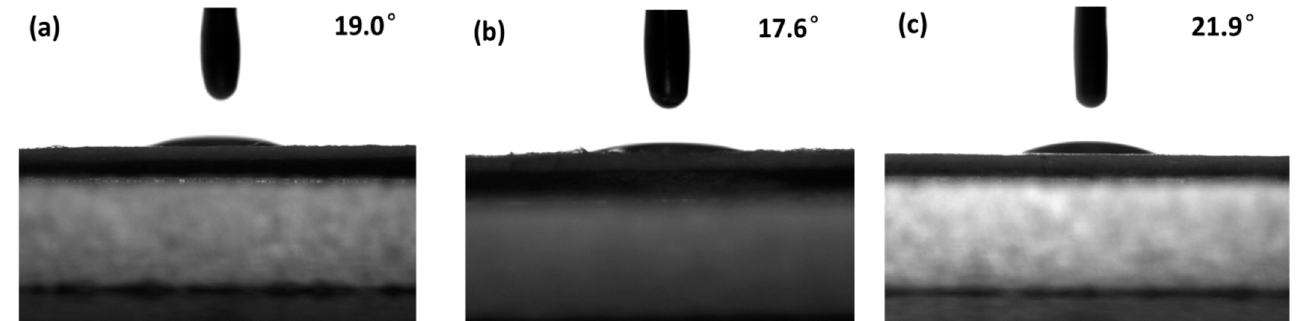
Figure 2. Oil contact angle of filter samples. ( a ) F7 cellulose filter, ( b ) F9 melt-blown filter, ( c ) E11 PTFE membrane-coated filter.